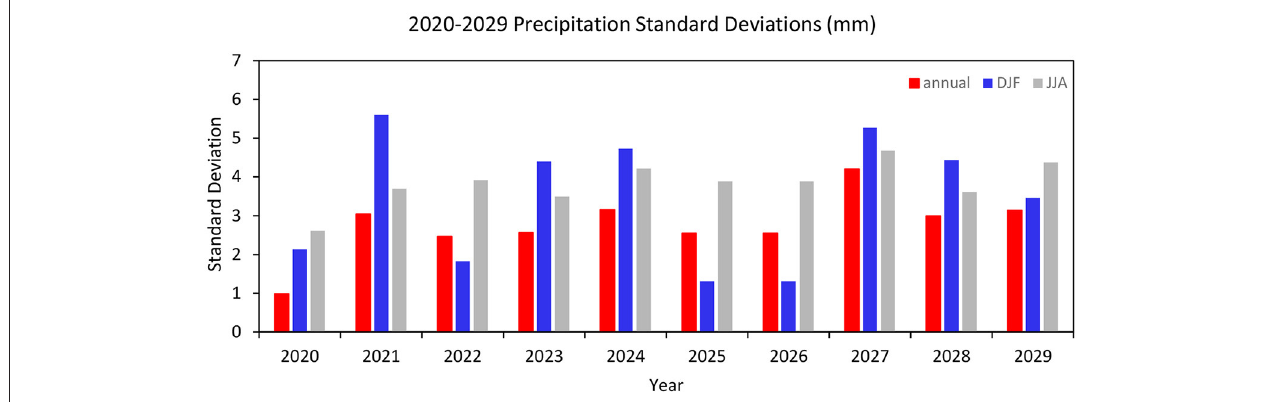
FIGURE 3 | The standard deviation of yearly annual and seasonal (DJF, JJA) means simulated between the years 2020 and 2029.